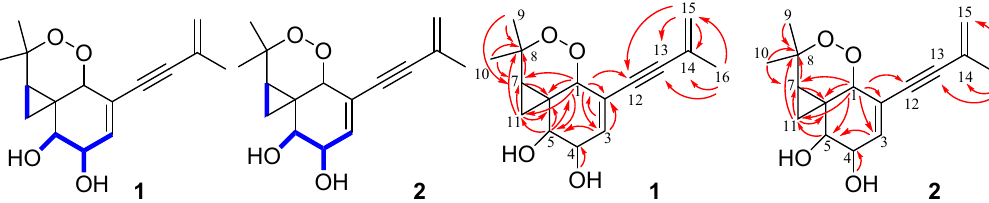
Figure 6. Key 1 H- 1 H COSY (blue lines) and HMBC (red arrows) correlations of compounds 1 and 2.